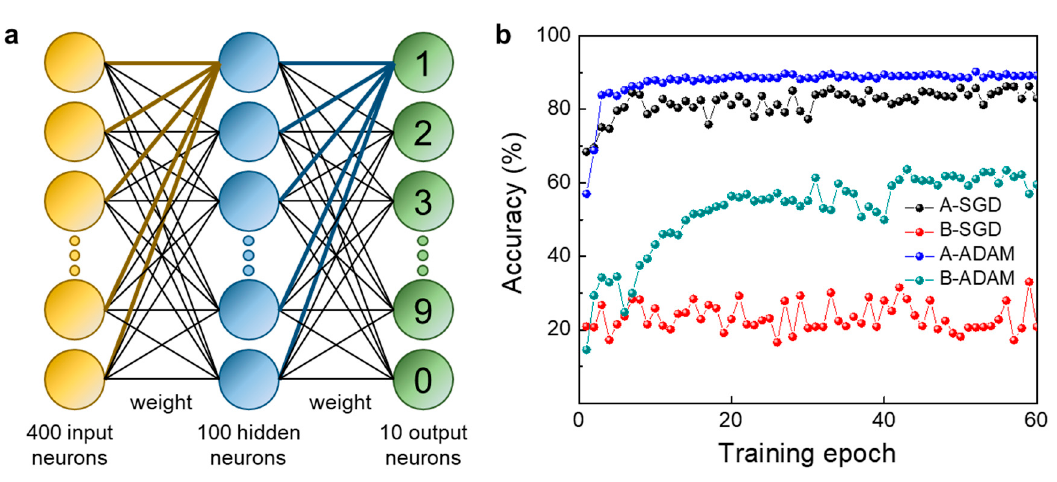
Figure 5. ( a ) A three-layer perceptron-based artificial neural network for Modified National Institute of Standards and Technology (MNIST) handwritten recognition, and ( b ) the accuracy with training epochs based on two pulse conditions and two algorithms which were stochastic gradient descent (SGD) and adaptive moment estimation (ADAM).